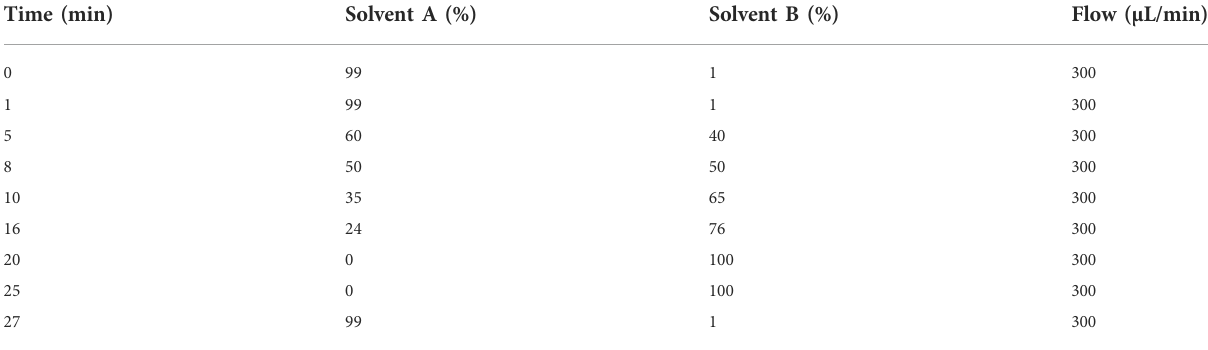
TABLE 1 Gradient elution